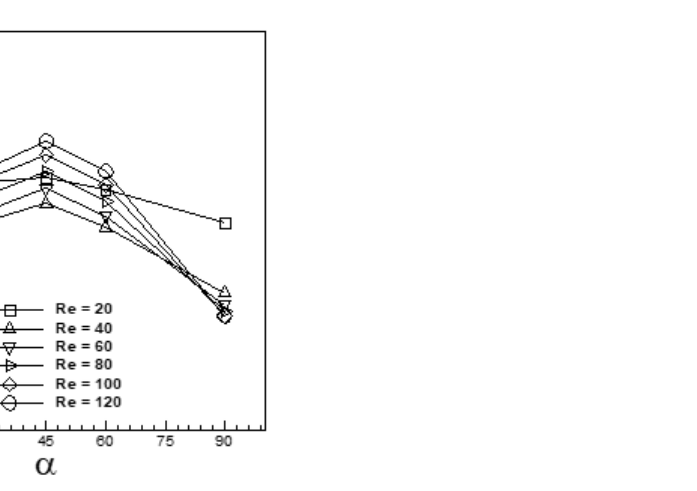
tions (Ri = 0, 20 ≤ Re ≤ 120 and 0 ° ≤ α ≤ 90 °).